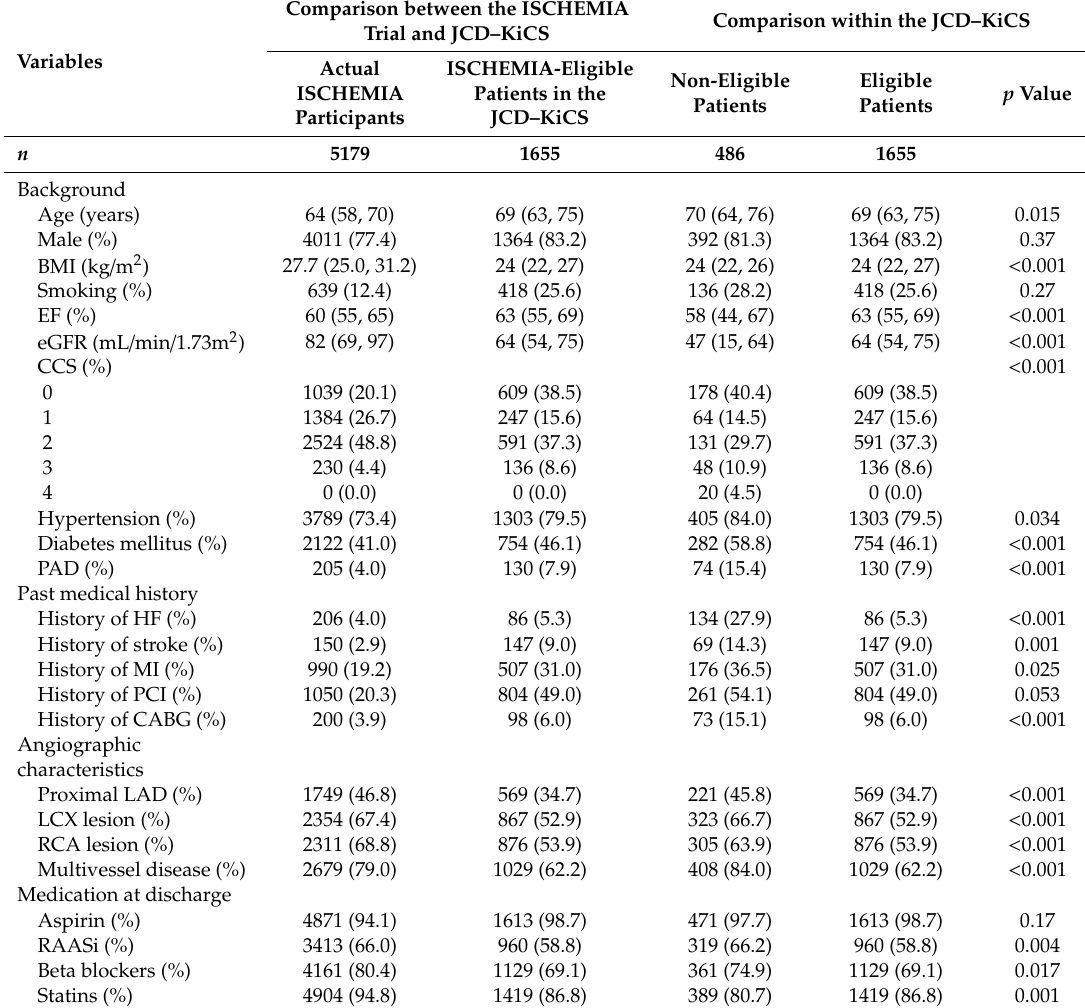
Table 1. Baseline characteristics in JCD–KiCS, and actual ISCHEMIA